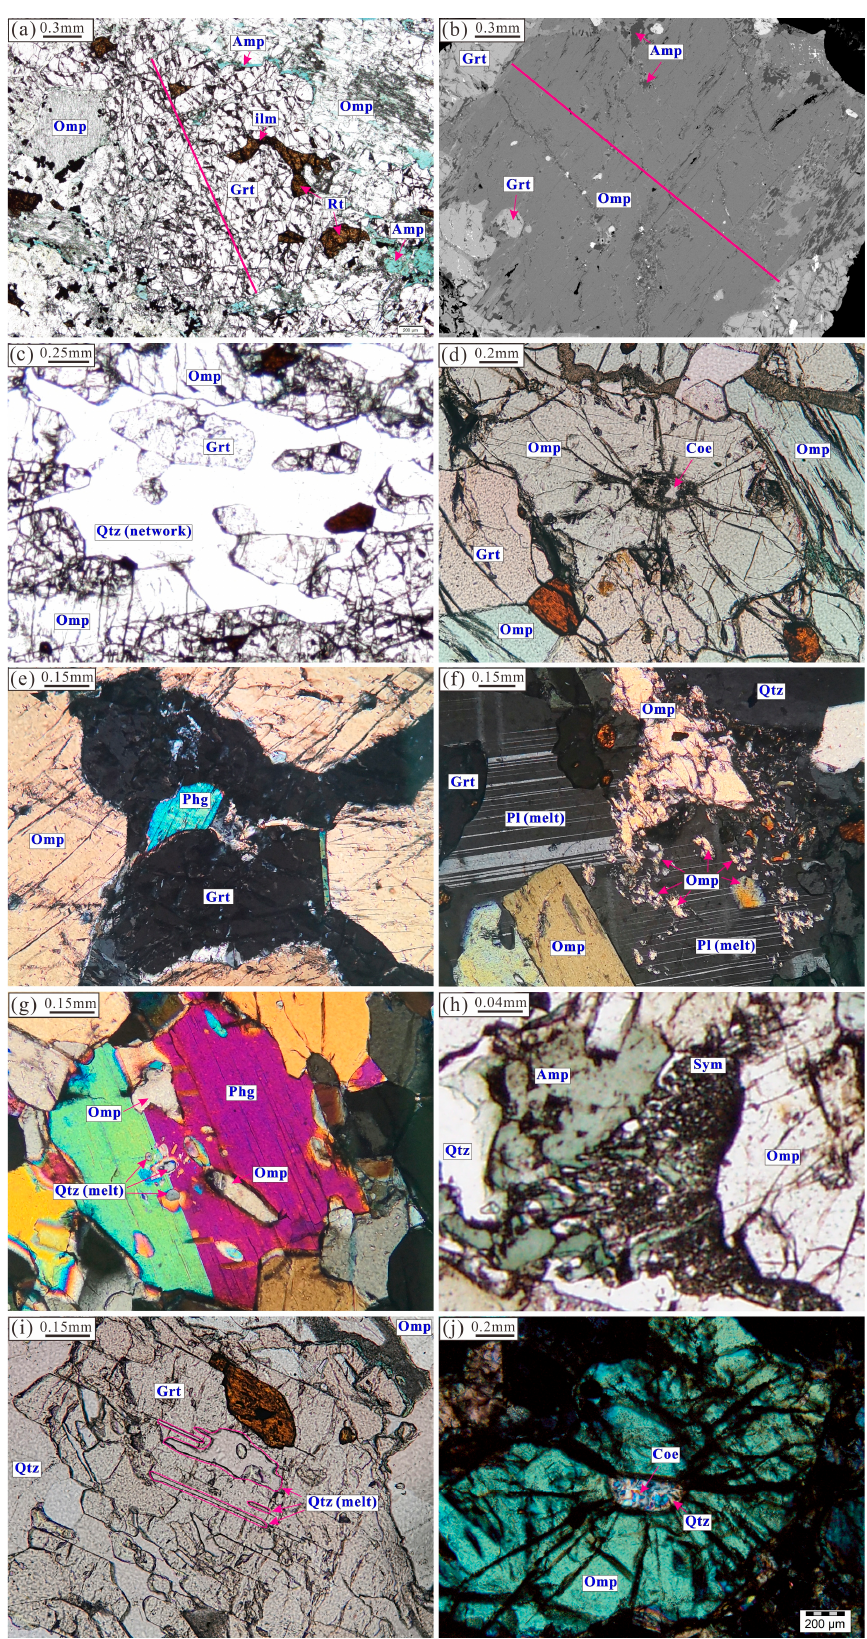
Figure 2. Photomicrographs and BSE images of eclogite samples in the Guanshan and Yangkou. ( a ) Garnet contain rutile inclusions and rutile breakdown to form ilmenite during the retrograde metamorphism; Sample G-10. ( b ) Omphacite is subhedral-anhedral granular, with core-rim texture;